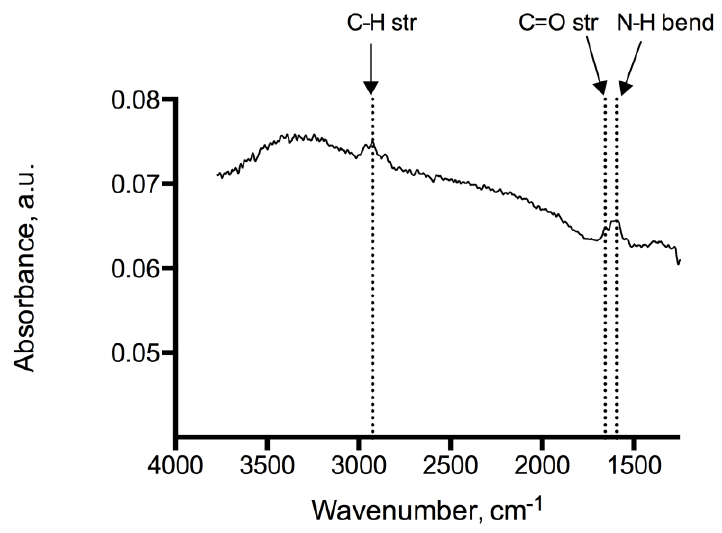
Figure 3. IR-spectrum of the adenine coated silicon wafers showed peaks at 1595–1657 cm −1 and 2858–2925 cm −1 typical for C=O, N–H and C–H stretching modes.